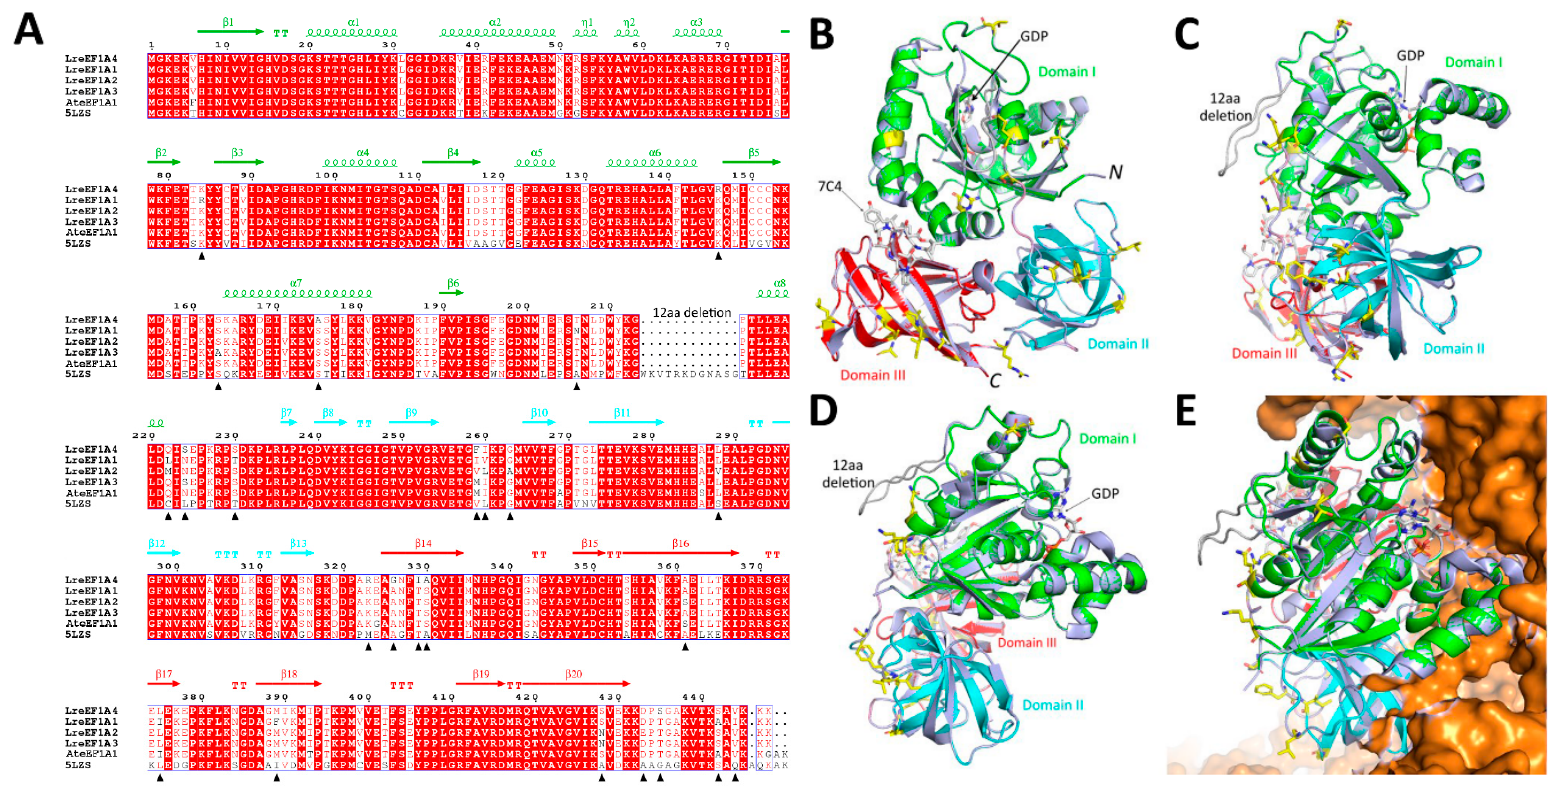
Figure 2. Protein structural modelling of LreEF1A4. ( A ) Amino acid sequence alignment of LreEF1A4 with other homologs, including Lilium regale LreEF1A1–3, Arabidopsis AteEF1A1, and mammal 5LZS. The secondary structure is displayed above the sequences in green (domain I), cyan (domain II), and red (domain III). Amino acid substitution sites within LreEF1A1–4 are indicated with solid triangle. ( B–D ) Structural superimposition of LreEF1A4 model with mammalian eEFA1 5LZS (blue) in different angles. ( E ) Spatial orientation of LreEF1A4 in complex with ribosomal proteins (orange). Domain I, II, and III are highlighted in green, cyan, and red, respectively. Amino acid substitution sites within LreEF1A1–4 are shown in yellow sticks.